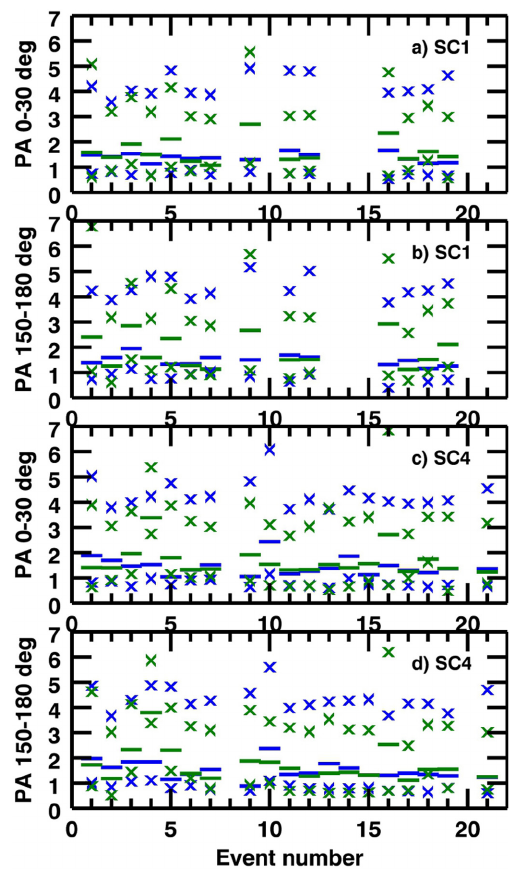
Fig. 5. Median normalized inflow electron flux (green lines) and outflow electron flux (blue lines) for each ion diffusion region en- counter (see Table 1). A value greater than 1 means that the parallel/anti-parallel flux dominates over the perpendicular. Green crosses: inflow first and third quartiles, blue crosses: Outflow first and third quartiles. (a) Cluster spacecraft 1, 0 ◦ − 30 ◦ pitch angle bin (parallel). (b) Cluster spacecraft 1, 150 ◦ − 180 ◦ pitch angle bin (anti-parallel). (c) Cluster spacecraft 4, 0 ◦ − 30 ◦ pitch angle bin. (d) Cluster spacecraft 4, 150 ◦ − 180 ◦ pitch angle